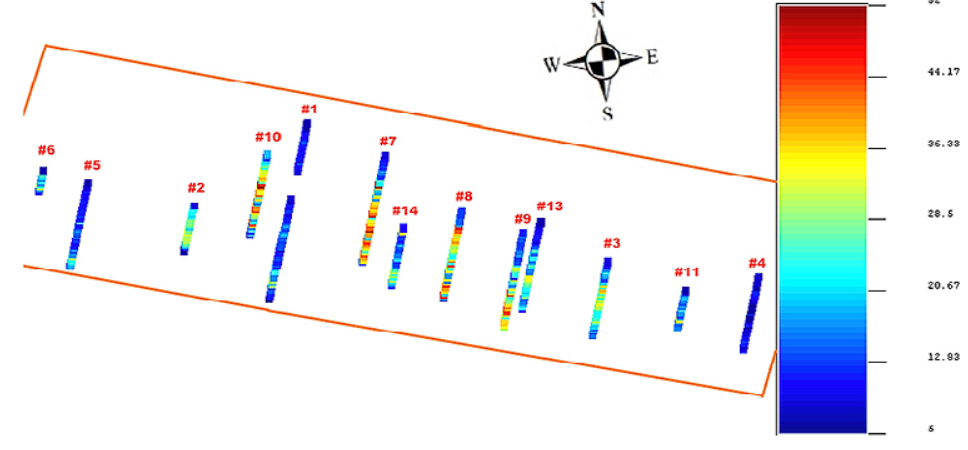
Figure 7a. R Well Data Logs with well ID numbers within study area boundary